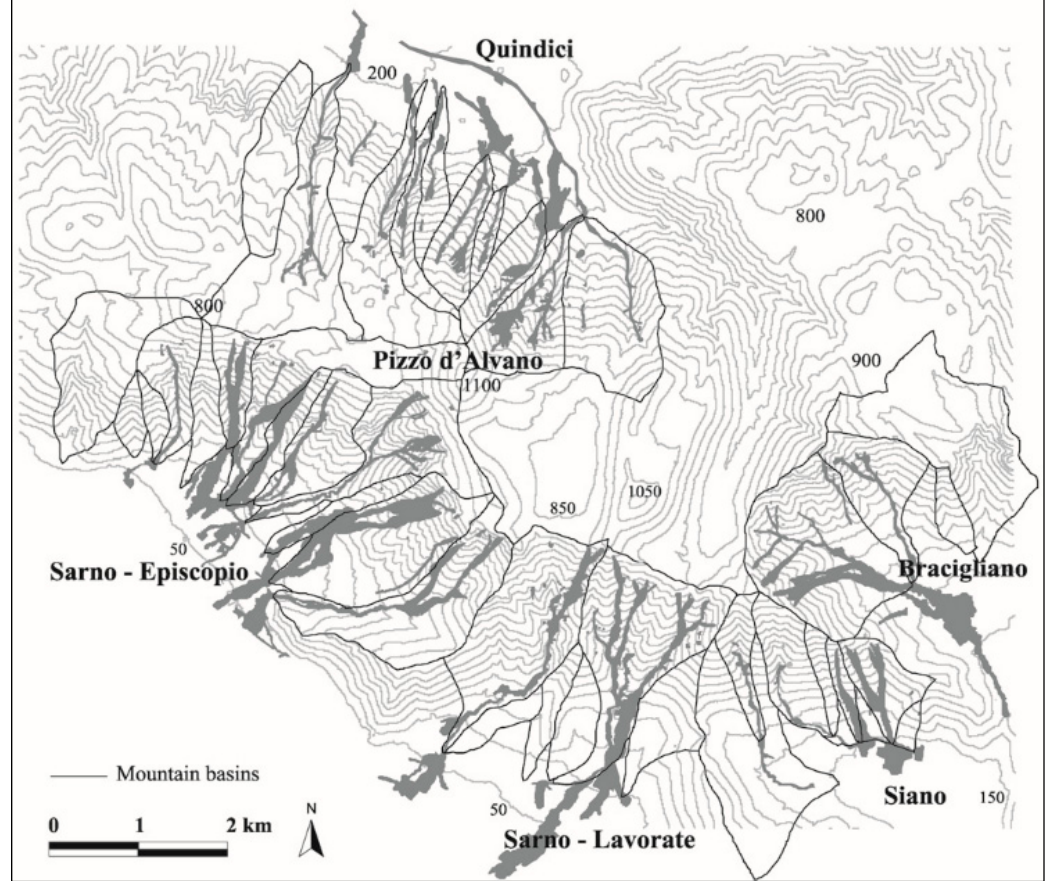
Figure 18. Debris flows involving the pyroclastic deposits lying on the limestone bedrock at Pizzo